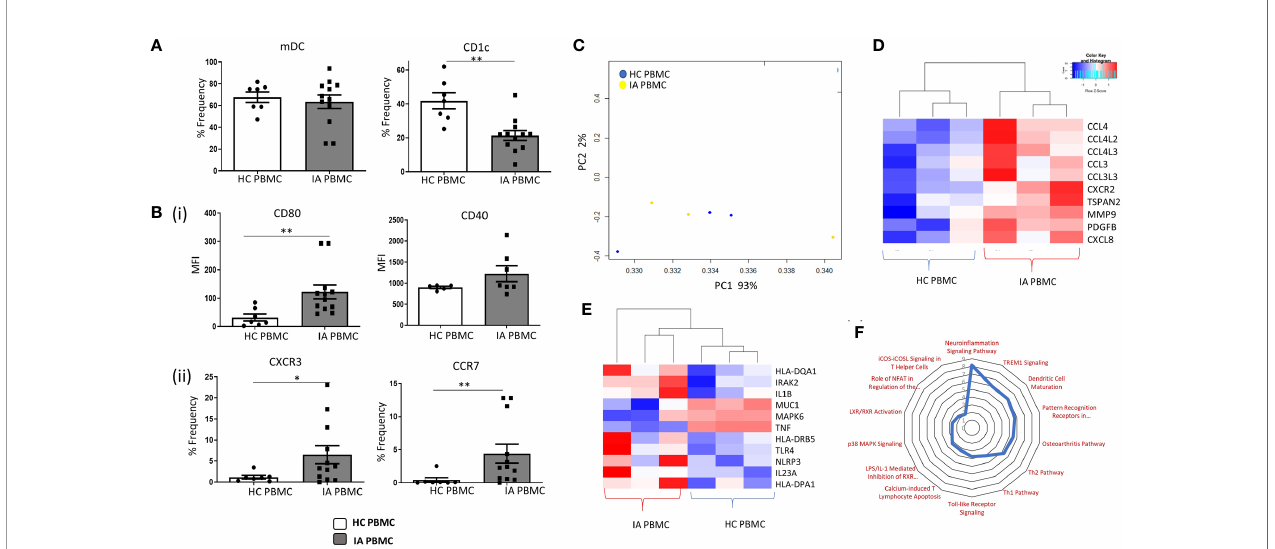
FIGURE 1 | Enhanced Maturation and Migratory Capacity of Circulating CD1c+ DCs in IA. (A) The percentage frequency of mDCs and CD1c + DCs in HC peripheral blood (n = 7) and IA peripheral blood (n = 12). mDCs were gated as Lineage- HLADR + CD11c + , while CD1c + DCs were gated based on the expression of CD1c within the mDC population. (Bi) Median Fluorescence Intensity (MFI) of CD80 and CD40 on CD1c + DCs from IA (n = 7 – 12) and HC peripheral blood (n = 5 – 7). (Bii) Percentage frequency of CXCR3 + and CCR7 + CD1c + DCs in IA (n = 12) and HC peripheral blood (n = 7). (C) RNA sequencing isolated CD1c + DCs from HC (n=3) and IA peripheral blood (n = 3). PCA of total datasets from HC and IA peripheral blood. (D) Clustered heatmap representing DEG involved in DC Maturation and (E) migration. (F) Radar plot representing enriched pathways in IA peripheral blood CD1c + DCs compared to HC using IPA. Non-parametric unpaired Mann Whitney U test was used. *p < 0.05, **p < 0.01 indicate groups that are signi fi cantly different from each